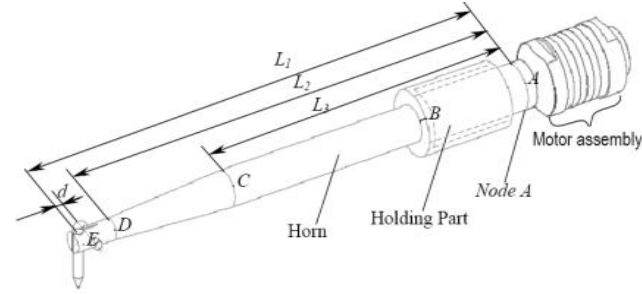
Figure 3. The geometry of the wire bonder transducer